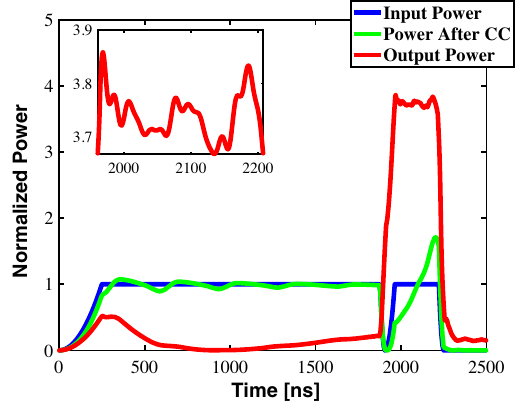
FIG. 15. Pulse shape of the pulse compression system based on the bowl-shape open cavities. The blue, green, and red curves are the input power, power after the correction cavity chain, and output power, respectively. The inset is given to show an enlarged view of output power. The Q 0 of storage cavity and coupling factor are 2 . 45 × 10 5 and 6.11. The Q 0 of correction cavity and coupling factor are 7 . 47 × 10 4 and 1.84.